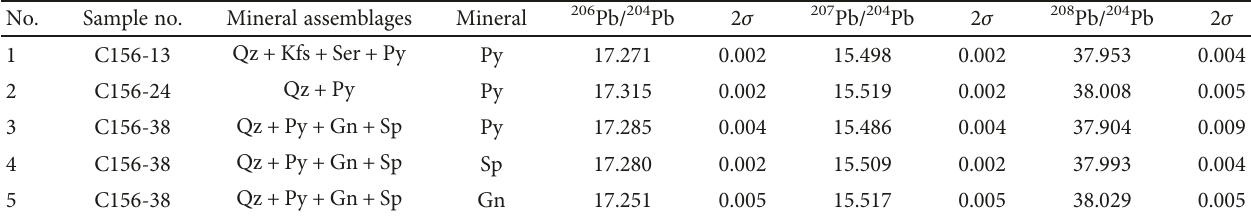
Table 5: Lead isotope compositions for sul fi des from the Xiejiagou gold deposit.